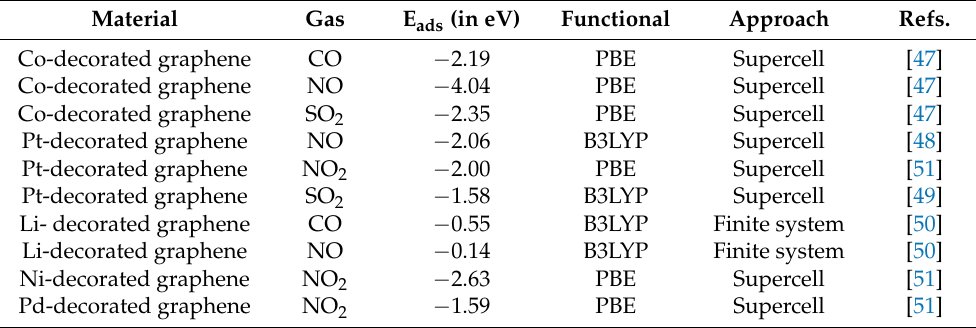
Table 2. Adsorption energies of toxic gases on transition metals decorated graphene.